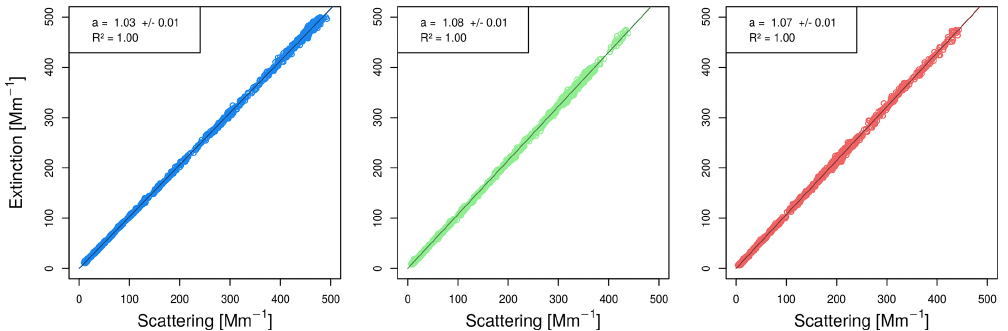
Figure 2. Comparison of measured extinction (450, 530 and 630nm) and scattering measured with a nephelometer (truncation corrected) for non-absorbing ammonium sulfate particles after the measured time